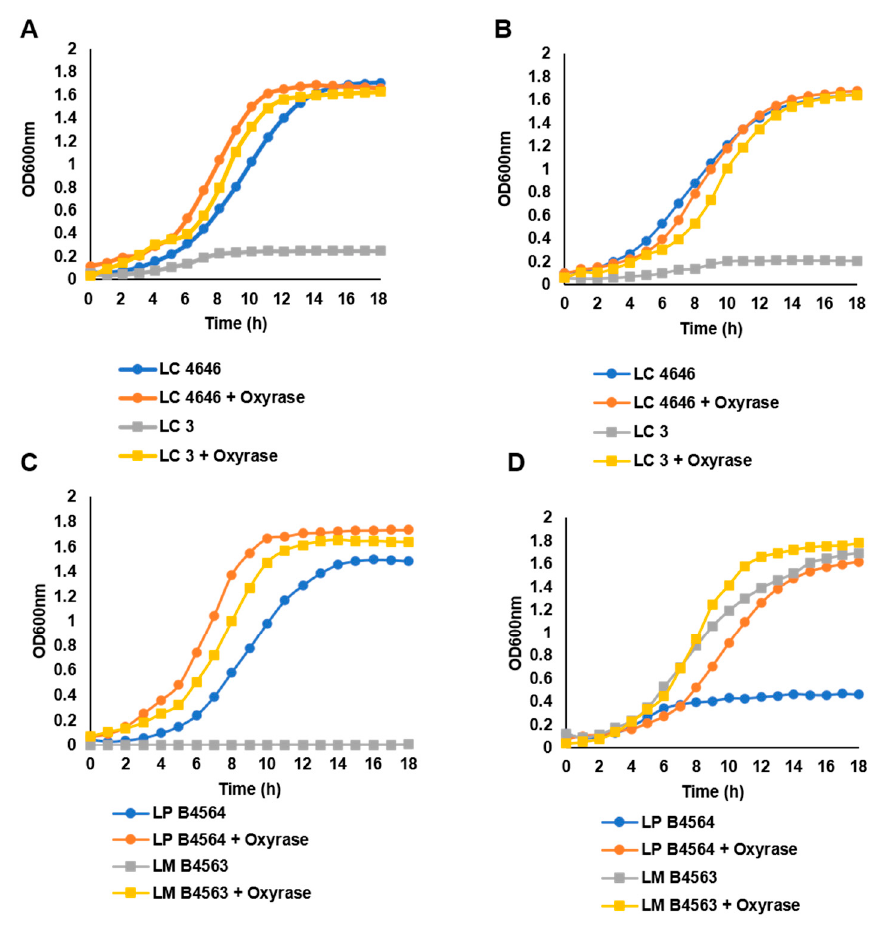
Figure 3. Growth of select Lactobacillus strains in mMRS broth containing ( A , C ) 1% FOS or ( B , D ) inulin at 32 ◦ C in the presence (orange and yellow symbols) or absence (blue and gray symbols) of Oxyrase, which was used to generate anaerobic growth conditions. Strains shown: L. casei strains 4646 (LC4646); LC3; L. paracasei B4564 (LP B4564); and L. mali B4563 (LM